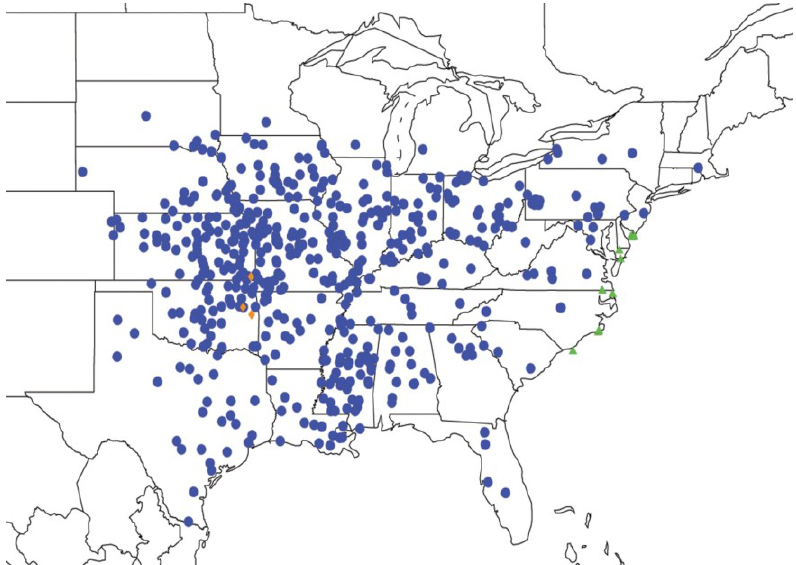
Figure 13. Distribution of Tibicen pruinosus pruinosus (blue circles), T. pruinosus fulva (orange diamonds) and T. latifasciatus (green